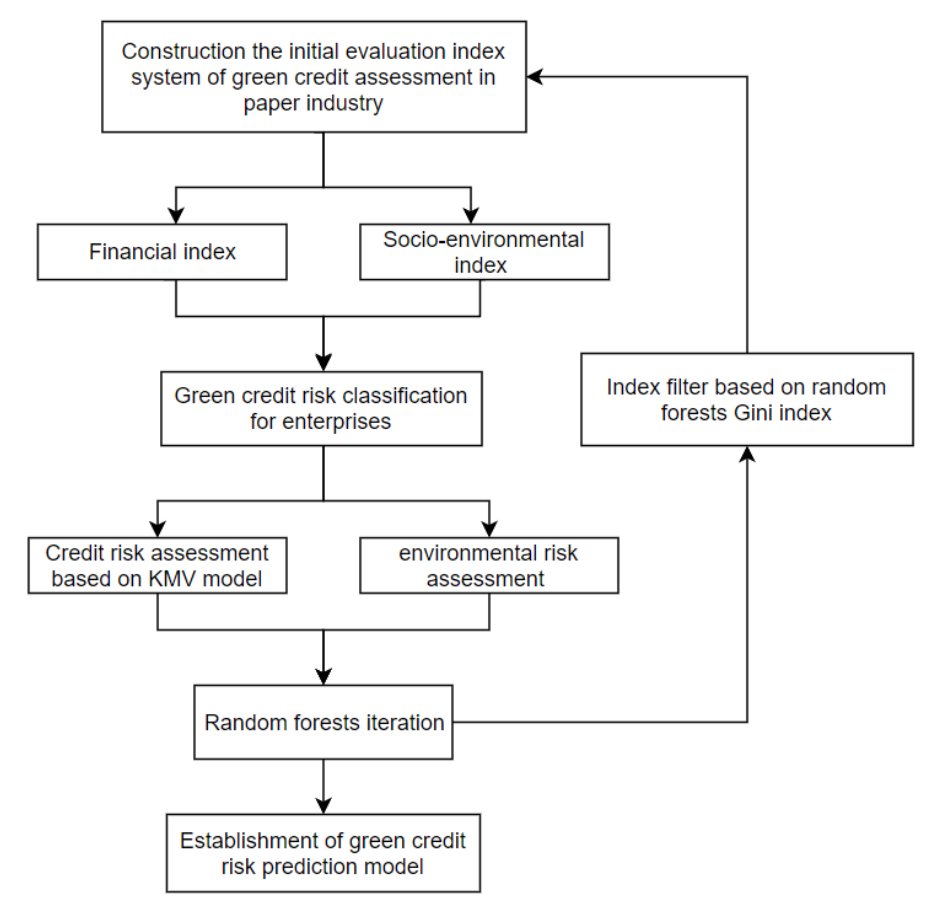
Figure 1. Flow chart of the study.